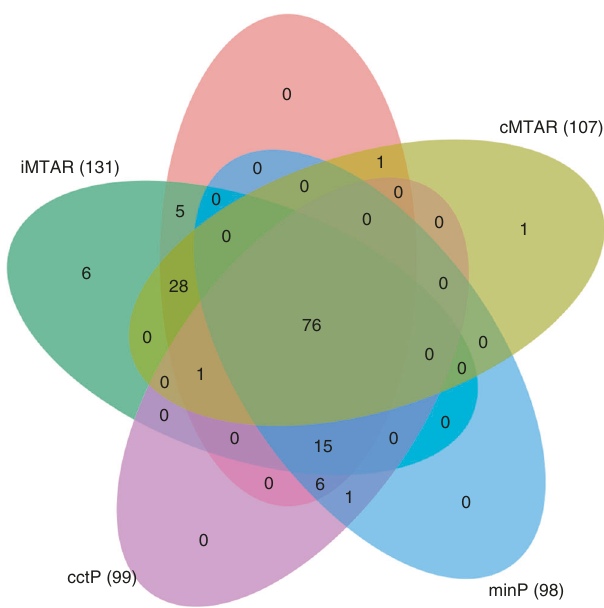
Fig. 2 Venn diagram of signi fi cant genes in the GLGC data analysis. MTAR-O, cMTAR, iMTAR, cctP, and minP test are performed and the number of signi fi cant genes identi fi ed by each method is shown in the